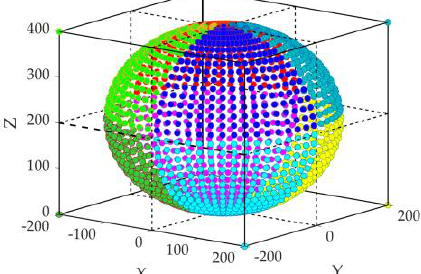
Figure 5. Schematic diagram of space partition.